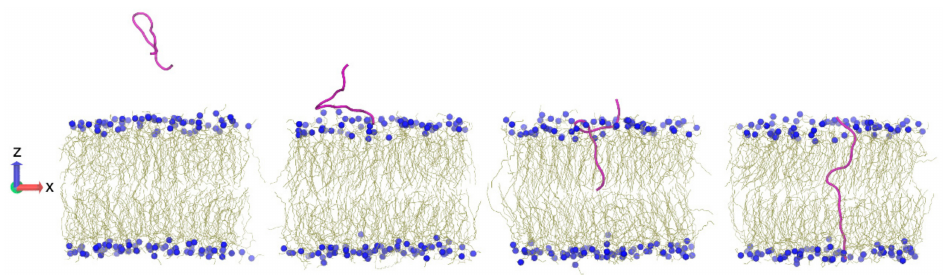
Figure 8. Translocation of pVEC across the lipid bilayer examined using SMD simulations [304]. Using CPPs for drug delivery into the cell has been a topic of interest. With the recent application of pVEC to cross the blood brain barrier [357], we believe that this CPP possesses significant potential for drug delivery